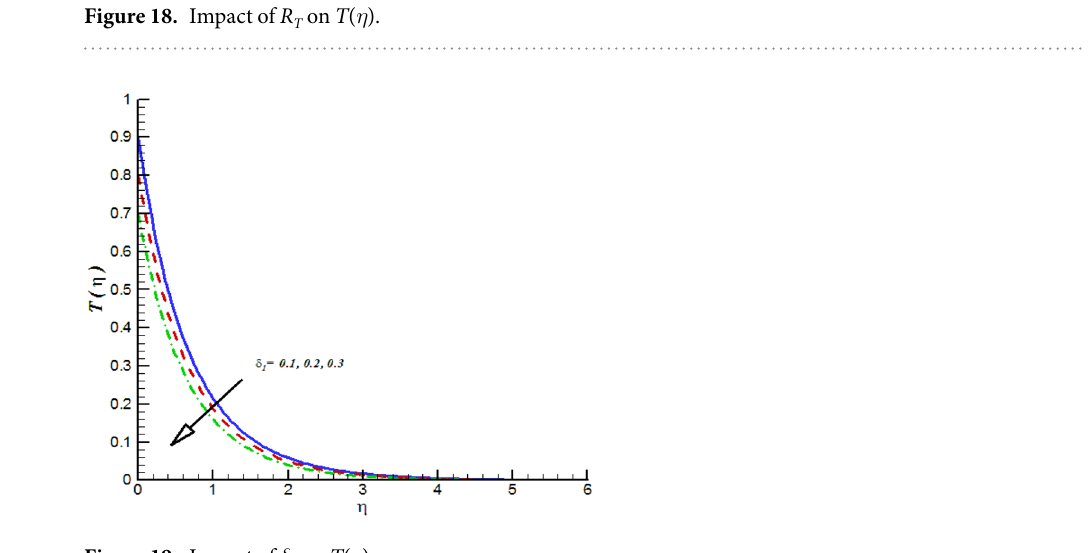
Figure 19. Impact of δ 1 on T ( η